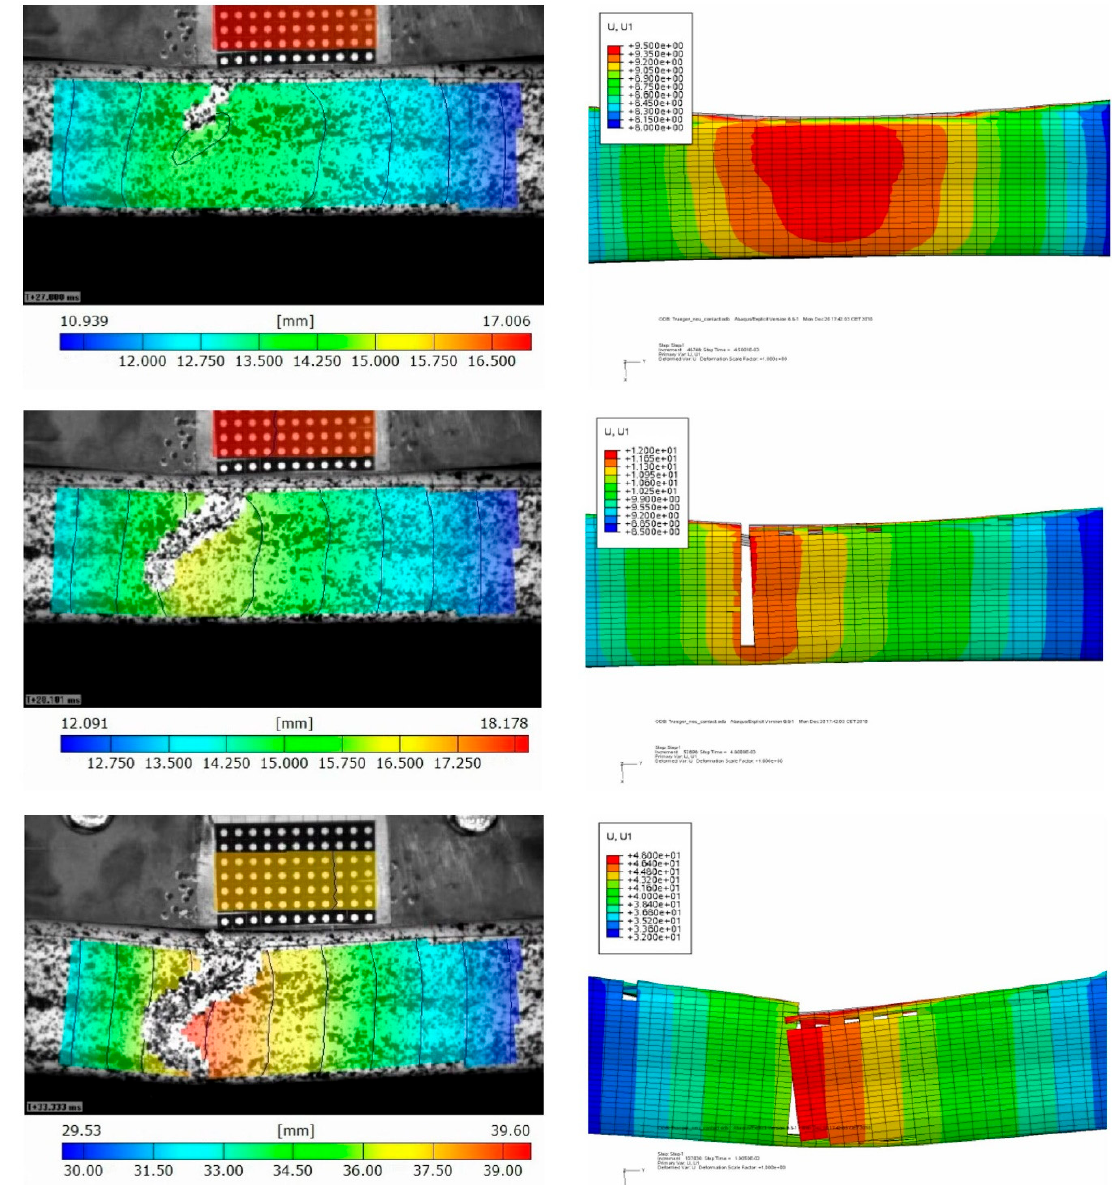
Figure 11. Comparison of experimentally observed ( left ) and numerically predicted ( right ) deformations of bumper bracket configuration (b), layup: 9 layers ±30° (2D biaxial braid), with m imp = 154 kg and v imp = 16 km/h: 2.5 μ s (edge failure), 4.5 μ s (crack initiation in lateral surfaces), 4.8 μ s (crack propagation) and 10 μ s (total failure).